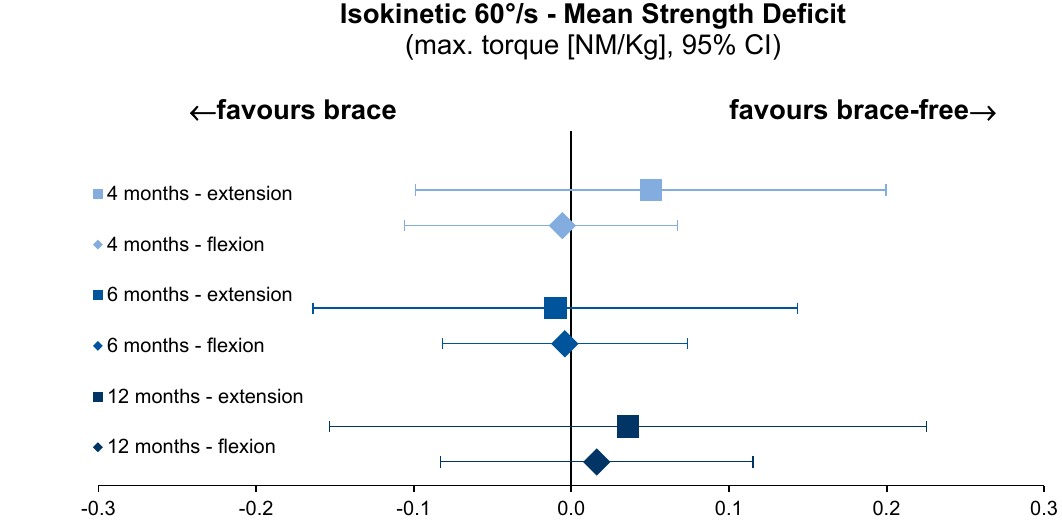
Figure 5. Mean strength deficit between ACLR and uninvolved leg, normalised to individual bodyweight for knee extension and flexion torque at 60 ◦ /s isokinetic testing velocity. ACLR, anterior cruciate ligament reconstruction. kg, kilogram. max., maximal. NM, newton meter. s, second.